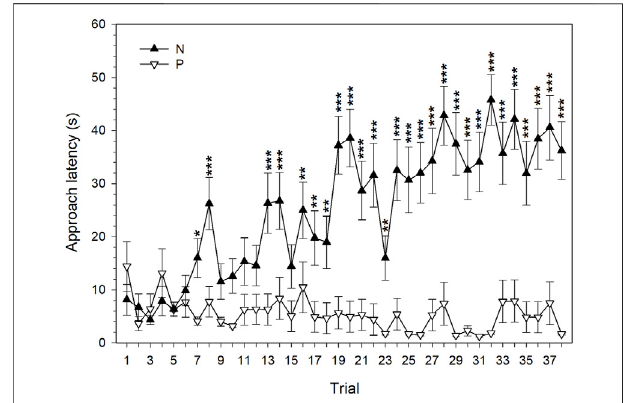
FIGURE 2 | The latency to approach the rewarded positive (P) and punished negative (N) feeder locations (mean ± SEM) by quail hens ( n =